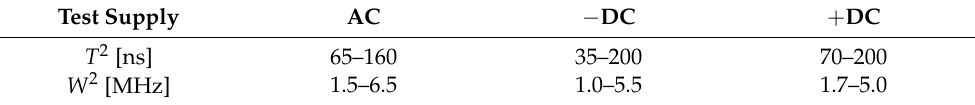
Table 5. Comparison of high temperature pulse characteristics at the three types of voltage